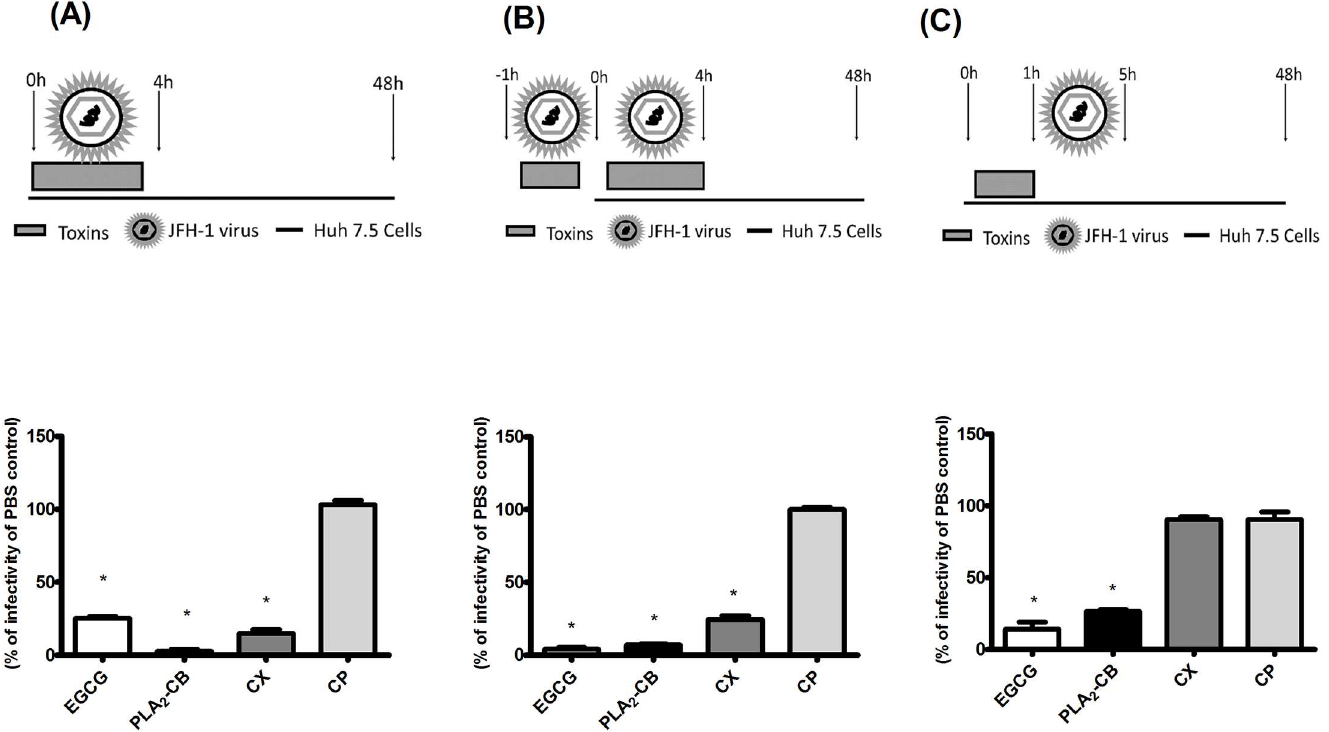
Fig 6. Effect of the toxins on HCV infectivity. Infectioussupernatantand toxins were added in different times to the cells and intracellularvirus was titrated 48 h post-infection by analyzingfocus-forming units per milliliters(Ffu/mL). For entry assay, Huh-7.5 cells were infected with JFH-1 HCVcc and toxins were immediately added. After 4 h, the supernatantwas replacedby fresh medium after repeatedwashes with PBS to remove completelythe inoculum(A). For virucidalassay, JFH-1 HCVcc particles were incubatedwith toxins for 1 h prior to the infection. After that, the inoculumwas used to infect na ï veHuh-7.5cells for 4 h. Cells were extensively washedand medium was added (B). In the pre-treatment assay, cells were previously treated with toxins for 1 h, washedto completelyremove toxins and infected with JFH-1 virus for 4 h. Cells were then washedto virus removaland replacedwith fresh media for up to 48 h post-infection (C). PBS was used as negativecontrol and EGCG as control of entry blockage.Mean values of three independent experiments each measuredin triplicate including the standard deviationare shown. P < 0.001 was consideredsignificant.